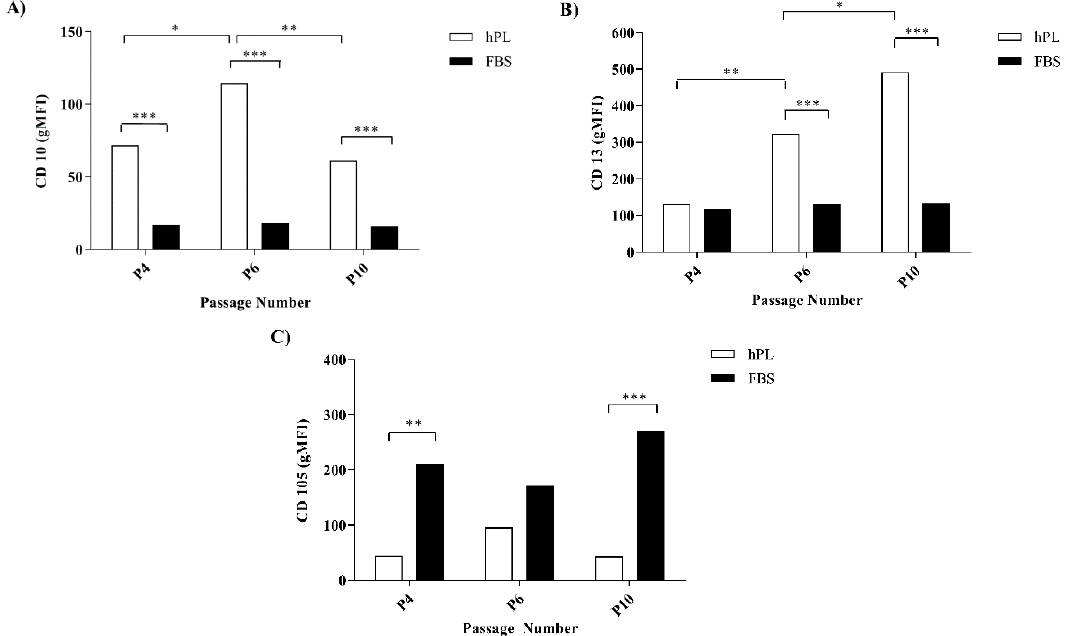
Figure 2. CD10 ( A ), CD13 ( B ), and CD105 ( C ) expression on the hES-MP cell surfaces over 10 passages. The CD10 expression was detected in the hPL–hES-MP cells at all passages, but not in the FBS–hES-MP cells. The CD13 expression was detected in all cultures with the hPL–hES-MP cells, demonstrating time-dependent increases, while the FBS–hES-MP cells showed constant expression. The CD105 expression was significantly lower in the hPL–hES-MP cells than in the FBS–hES-MP cells at all timepoints. (gMFI = geometric mean fluorescence intensity; * p ≤ 0.05; ** p ≤ 0.01; *** p ≤ 0.001).